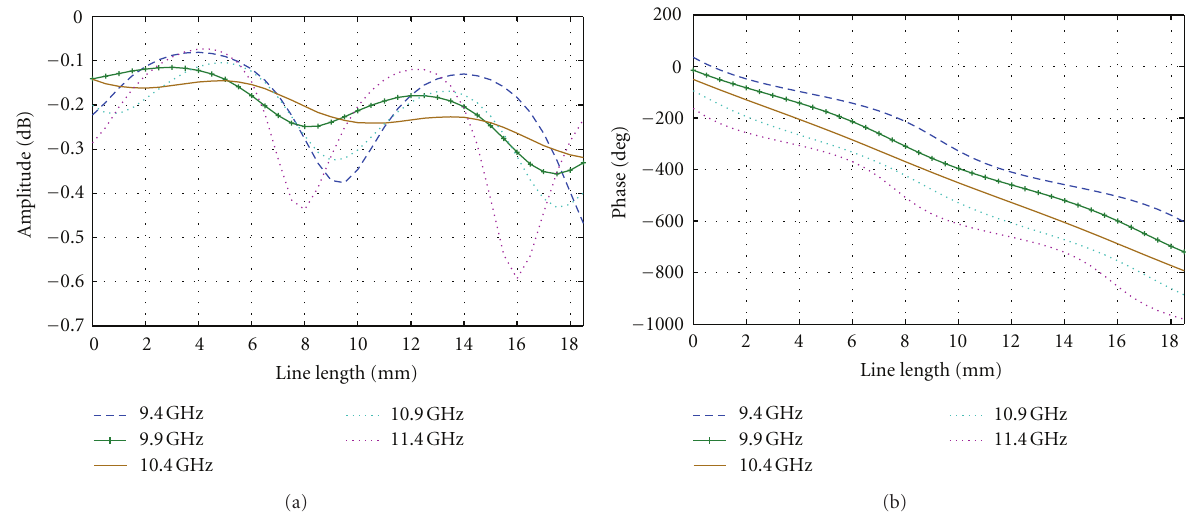
Figure 2: Modelling of the reflectarray element with phase control.